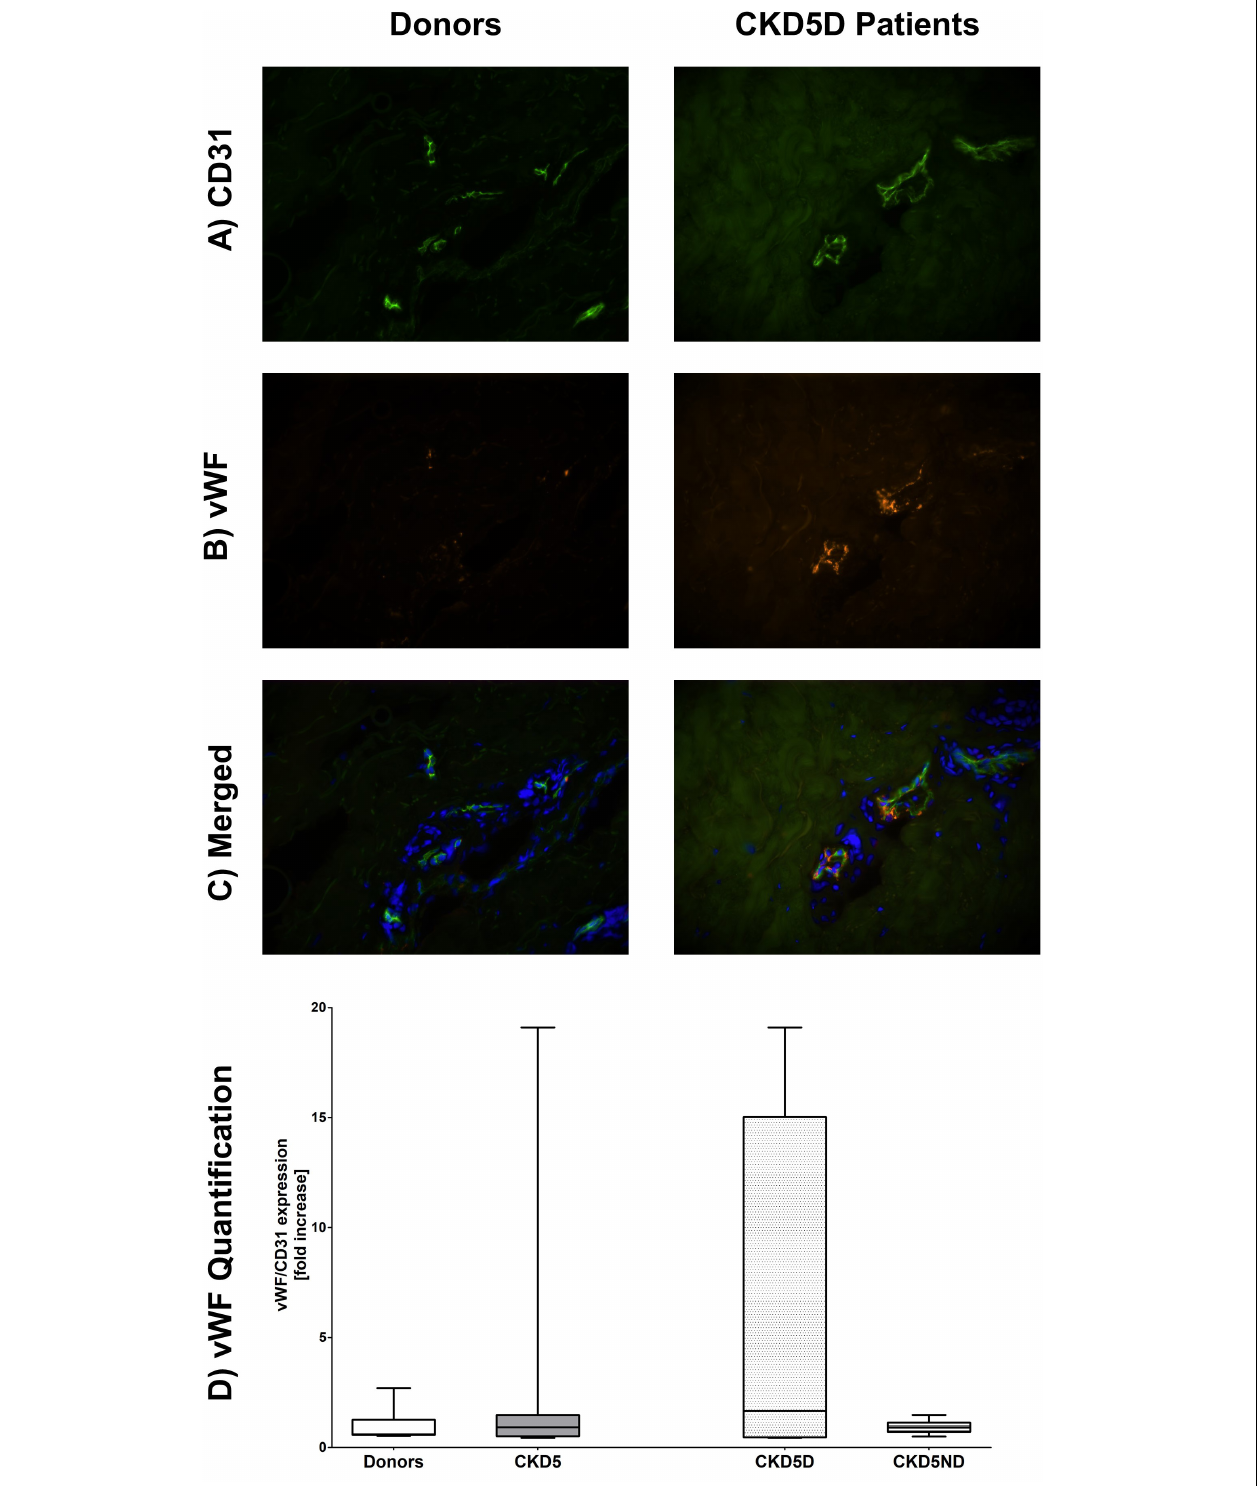
FIGURE 4 | Expression of vWF in the microvasculature of dermal biopsies in patients with CKD. (A) Expression of CD31 in donors (left image) and CKD5D patients (right image). (B) Expression of vWF in donors (left image) and CKD5D patients (right image). (C) Merged expression of vWF and CD31 in donors (left image) and CKD5D patients (right image). (D) vWF quantification with vWF expression relative to CD31. Colors in images: green = CD31; red = vWF; blue = DAPI. Differences between groups are not statistically significant.